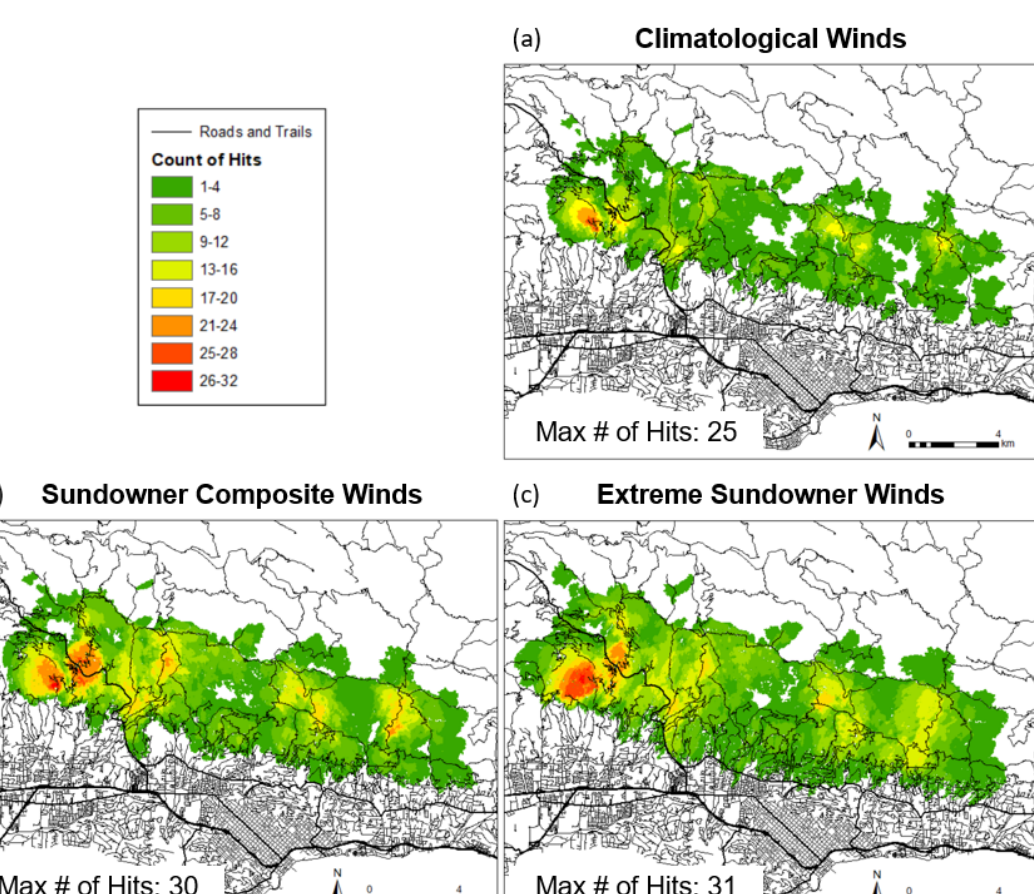
Figure 6. Similar to the subplots in Figure 5 showing the total number of hits at each grid cell, but all ignition methods were combined for ( a ) climatological wind input, ( b ) Sundowner composite wind input, and ( c ) extreme Sundowner case study wind input.